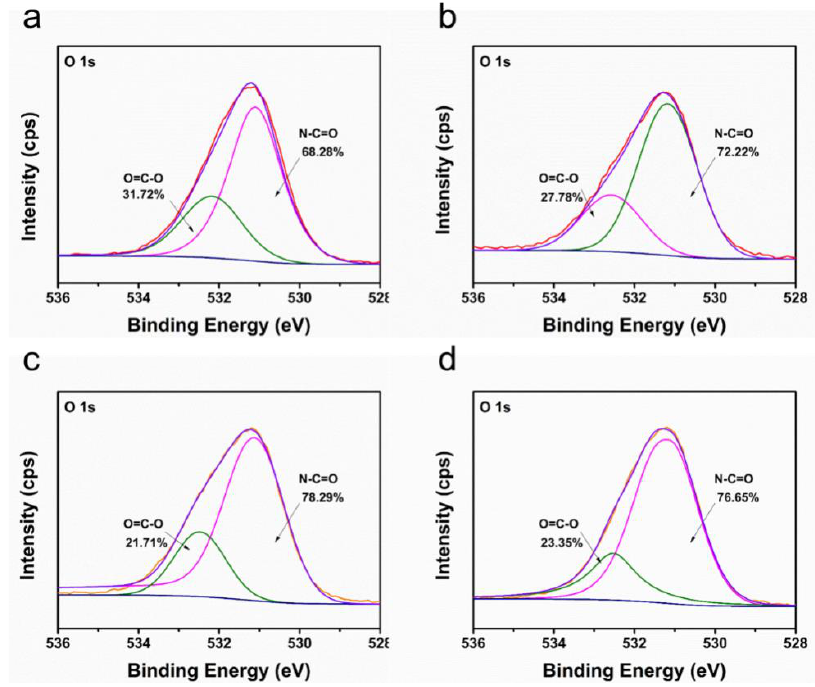
Figure 5. XPS O1s spectra of TFC-PA membranes prepared with different CNT deposition amounts (( a – d ) corresponding to TFC PA-1~4 membranes). (( a – d ) corresponding to TFC PA-1~4 membranes).